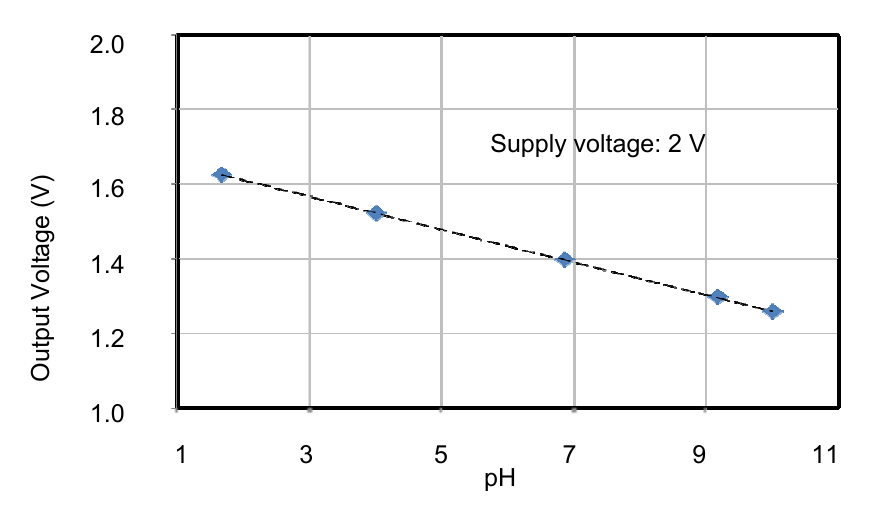
Figure 6. Characteristics of pH sensing area. The sensitivity of 43.8 mV/pH is sufficient for use as a pH sensor.